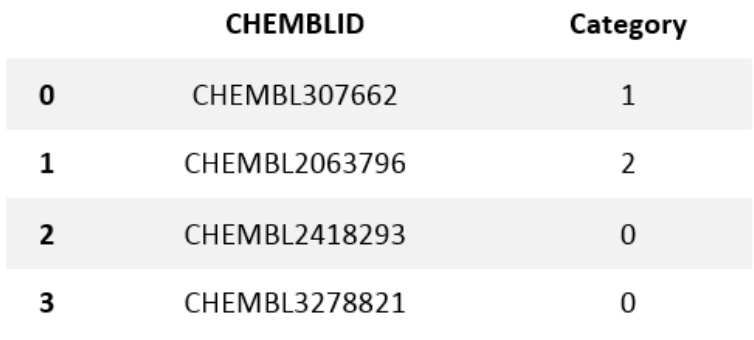
Figure 11. New molecule created with clusters assigned.